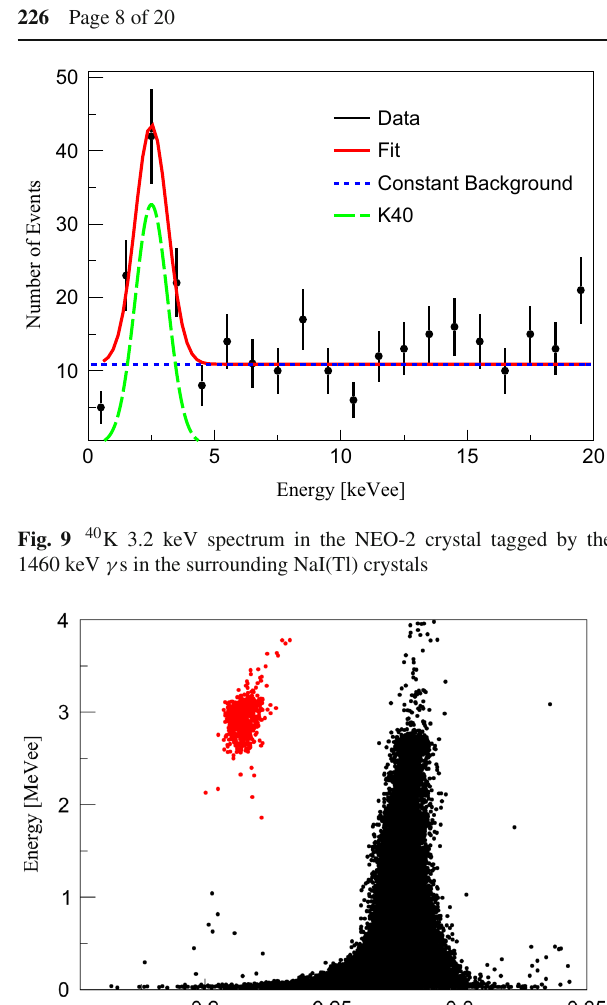
1.5 µ s time window from t 0 is used for the mean time